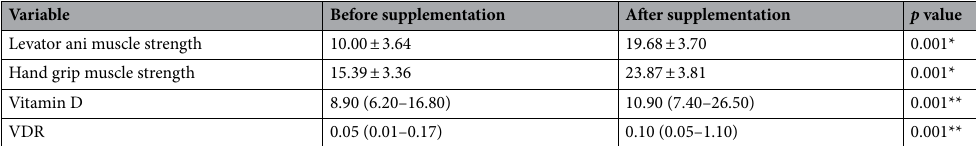
Table 2. Comparison of levator ani muscle strength, hand grip muscle strength, Vitamin D, and VDR before and after Vitamin D supplementation. *Dependent t test. **Wilcoxon test.